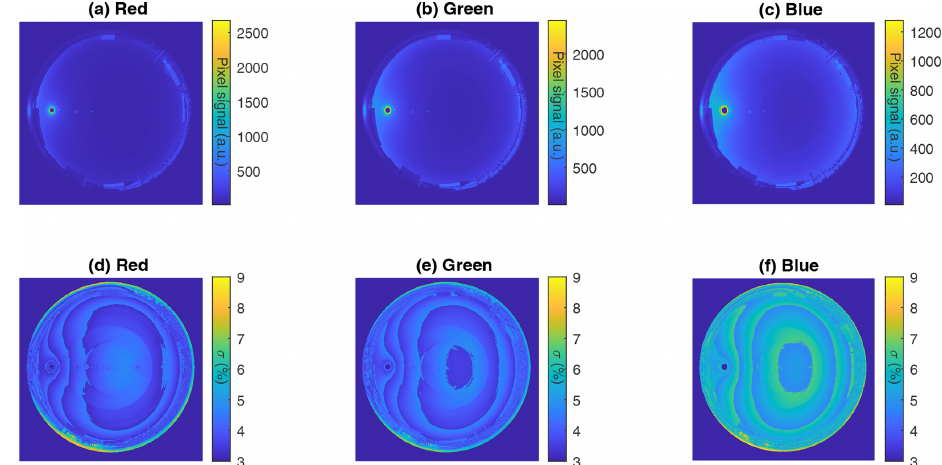
Figure 8. Linear HDR pixel signal (a–c) and its uncertainty (d–f) for the red (a, d) , green (b, e) and blue (c, f) channels at Valladolid on 17 August 2019 at